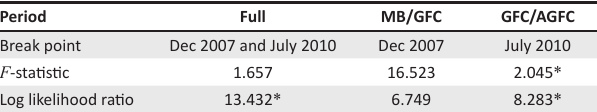
TABLE 5: Break point test